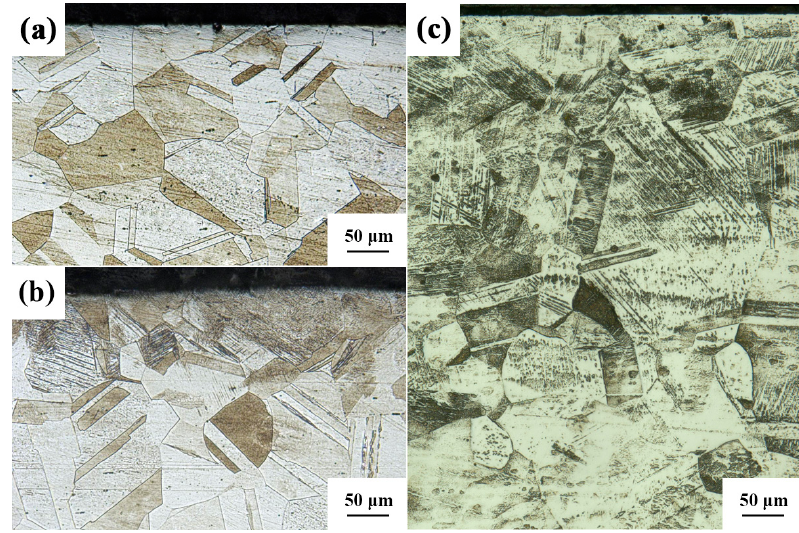
Figure 4. The cross-sectional microstructures of ( a ) BASE, ( b ) AWJP, and ( c ) UNSM specimens.